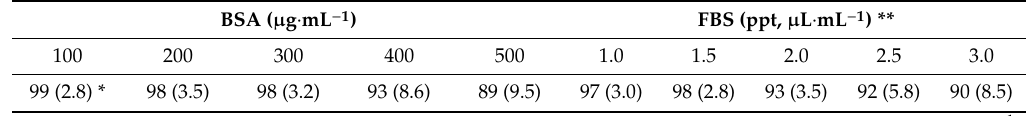
Table 1. Recoveries (%) of tetracycline (5.0 µ M) in phosphate bu ff er (pH 7.5, 50 mM) containing di ff erent concentrations of bovine serum albumin (BSA) and fetal bovine serum (FBS) by fluorescence determination with the